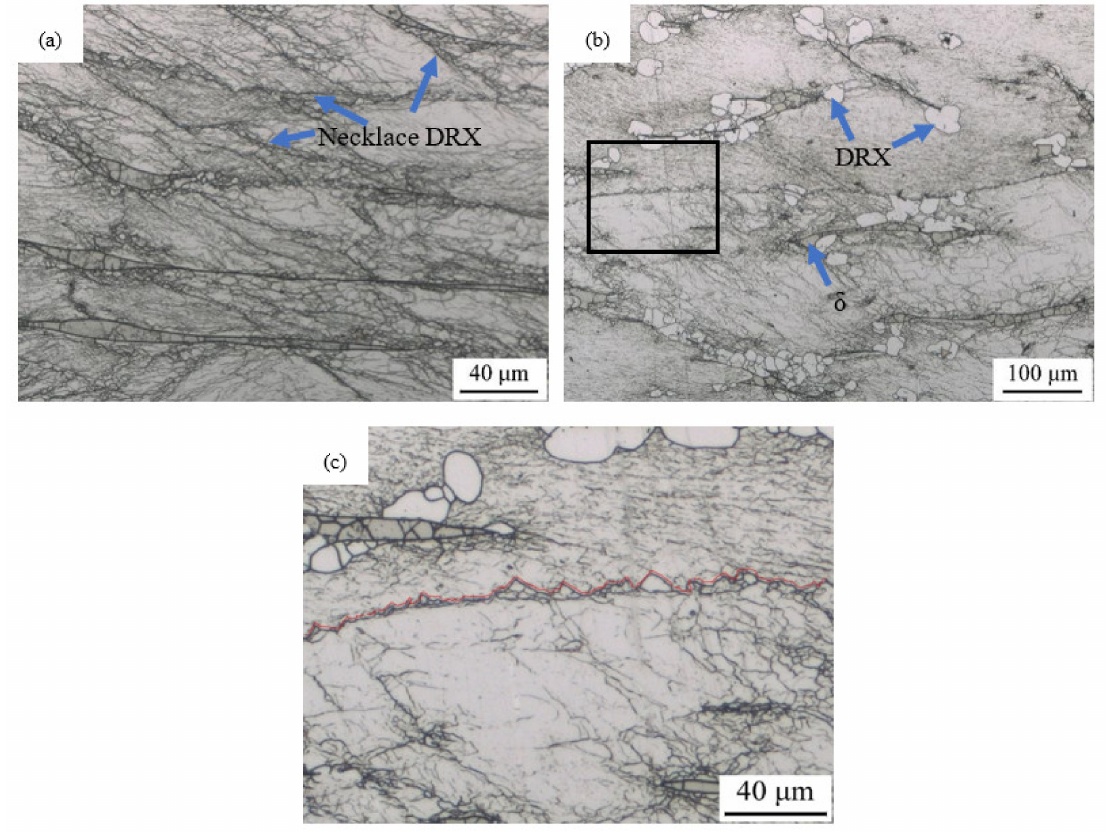
Figure 11. The microstructure of flow instability: ( a ) 1000 ◦ C, 1 s − 1 ; ( b ) 1100 ◦ C, 1 s − 1 ; ( c ) Enlargement of the black box area in ( b